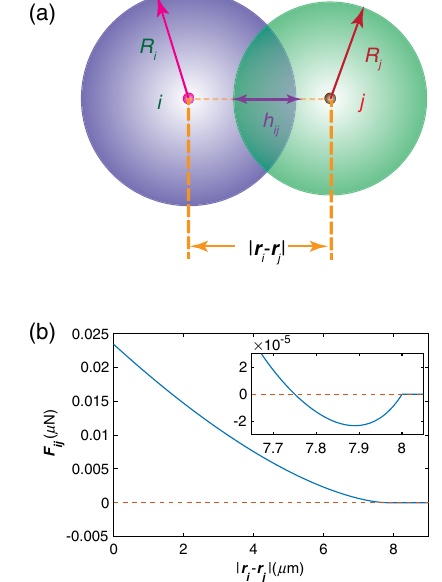
and i , ij is attractive. ij